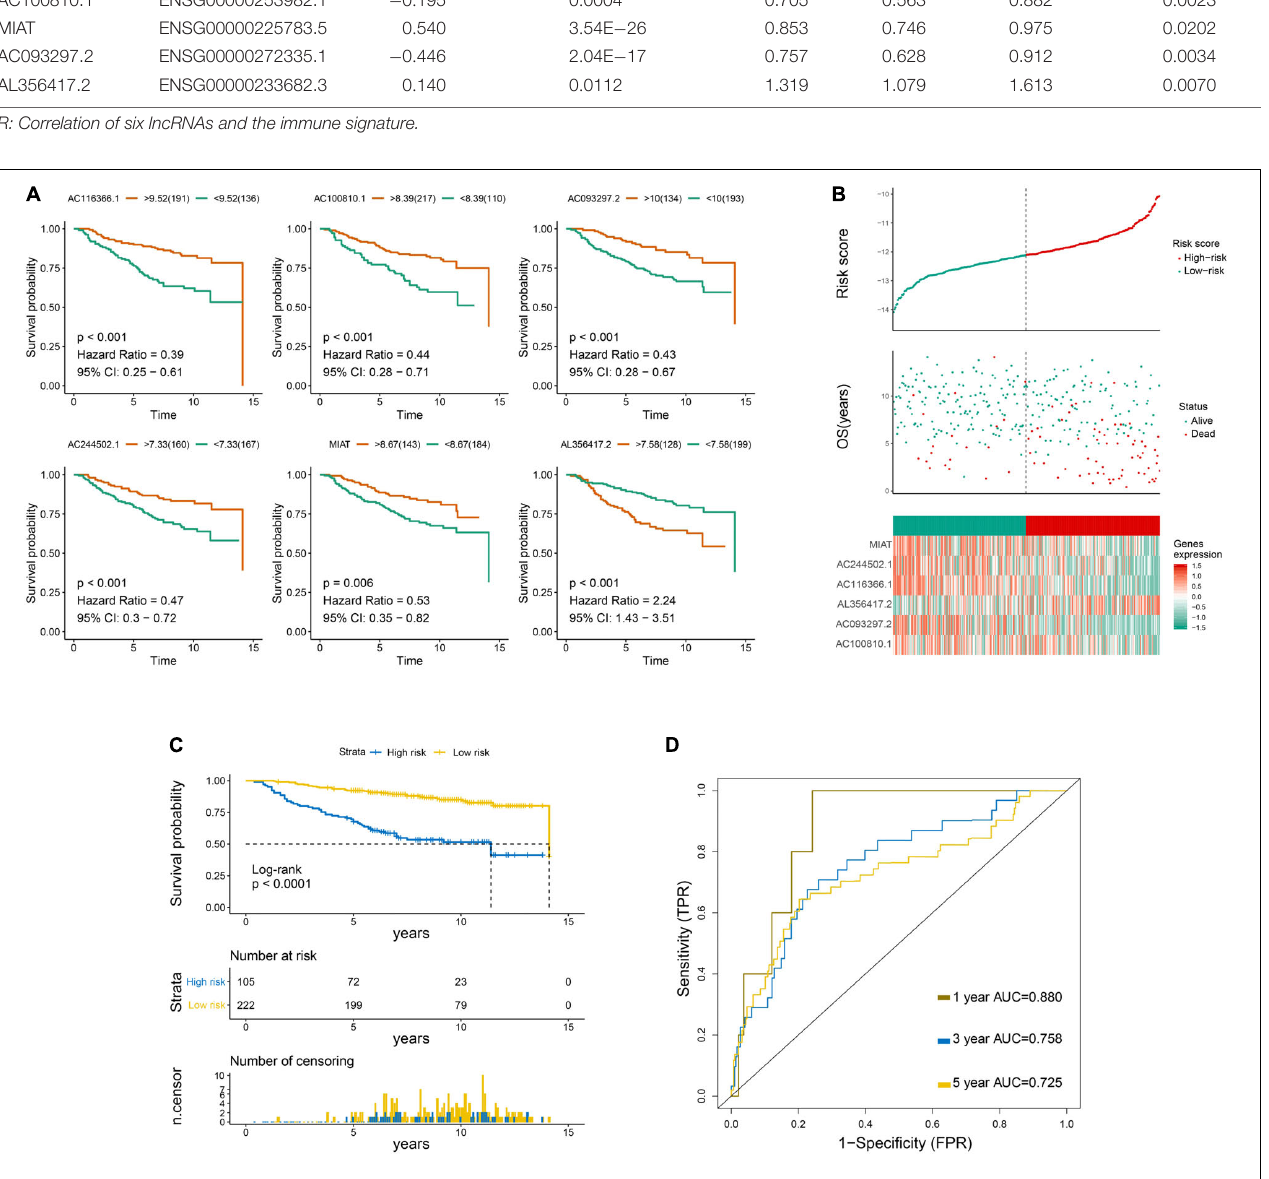
Frontiers in Genetics |